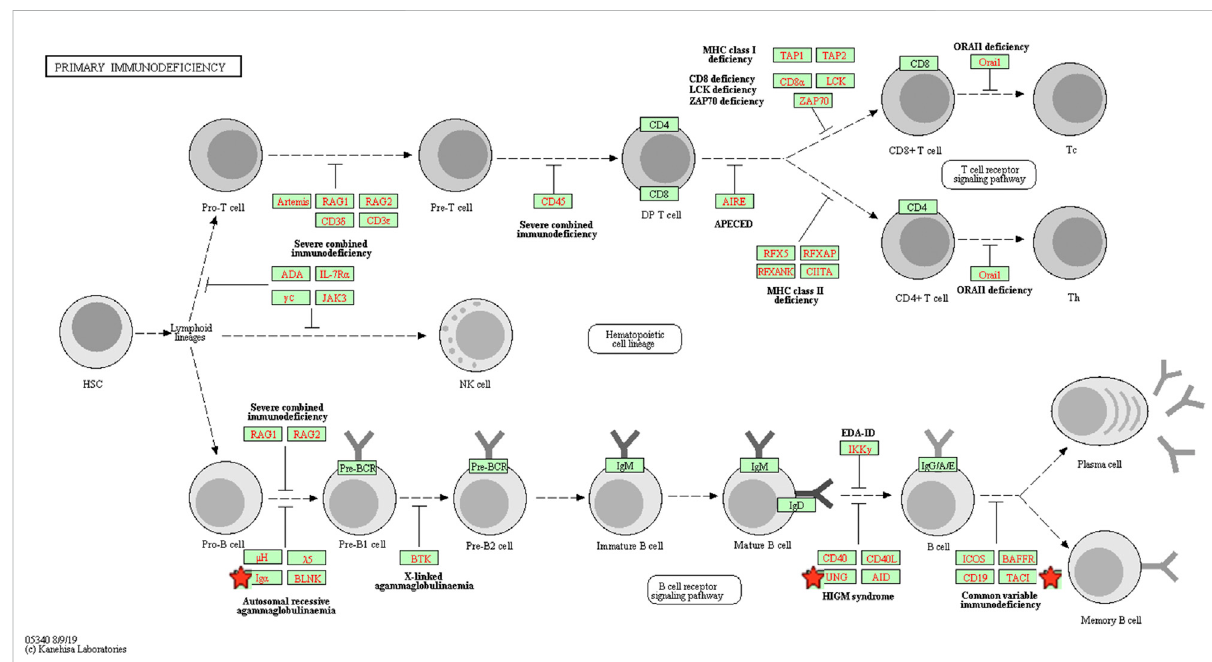
FIGURE 4 Theprimaryimmunode fi ciencysignalingpathwayenrichedinKEGG.Objectswithpentagramsareactinglocusbymappedgenes.KEGG,Kyoto encyclopedia of genes and genomes.